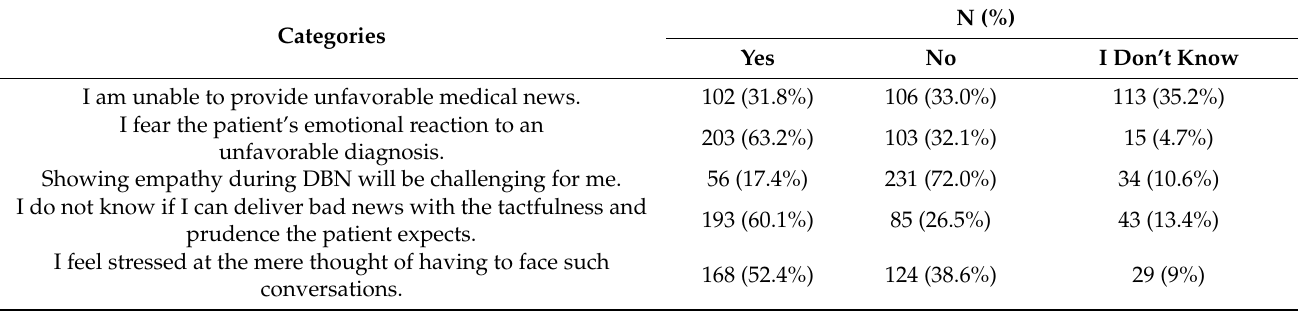
Table 2. Responses regarding DBN-related